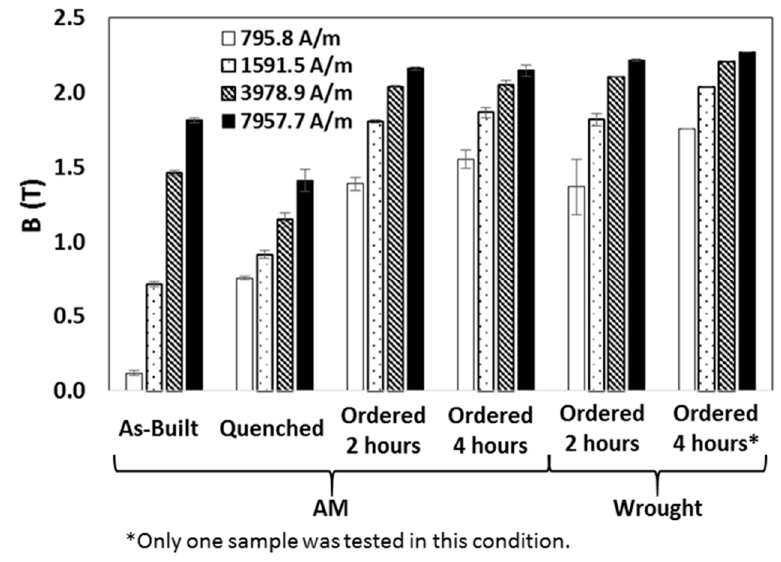
Figure 8. Magnetic saturation at various applied magnetic fields for AM and wrought samples.